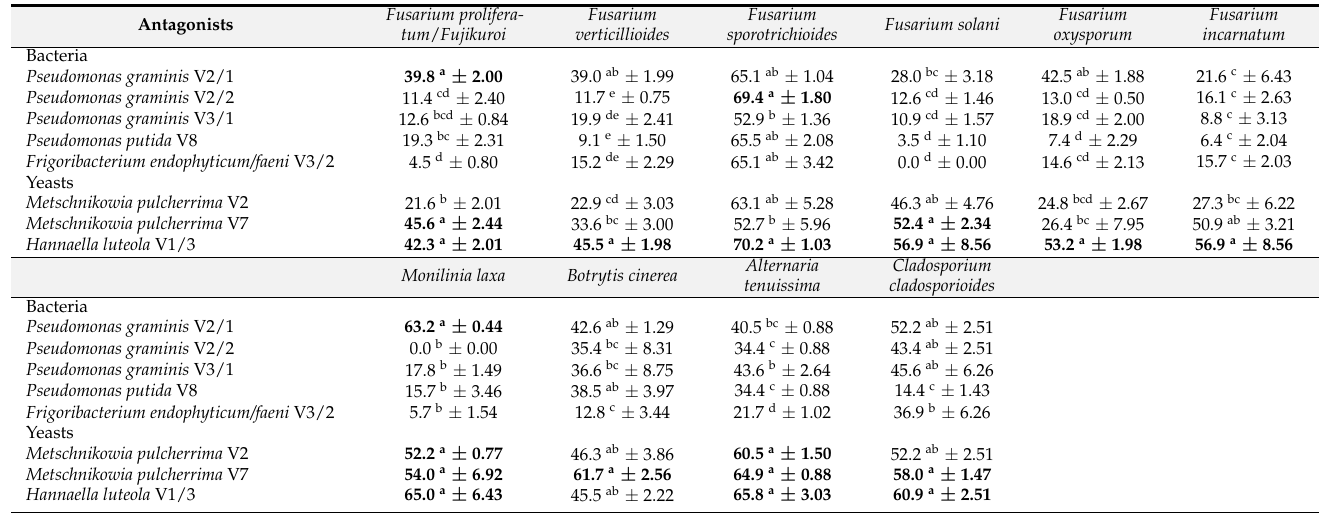
Table 2. Antifungal activity (mean ± SE) of supernatants from the antagonistic isolates on selected fungi in vitro, by a method of dual cultivation. The percentage inhibition of radial growth (PIRG%) as a measure of the antifungal activity was